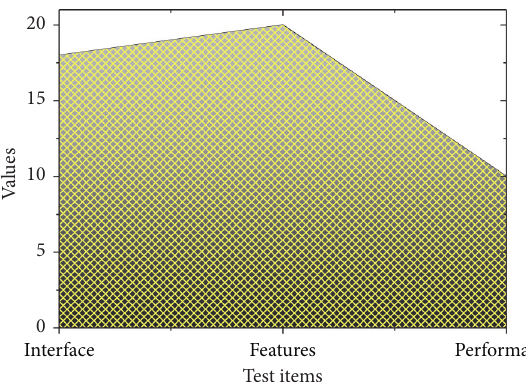
Figure 8: Test report of virtual simulation experimental system.